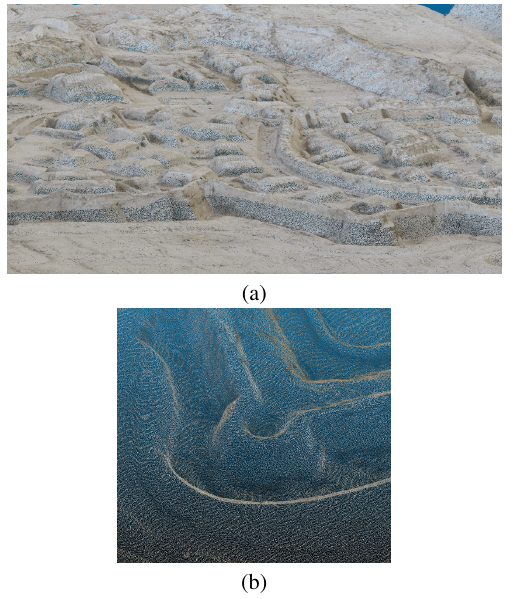
Figure 4. (a) Zoomed view of the reconstructed low relief. (b) Close view of “della Gatta” bastion, walls of Padova, Italy.